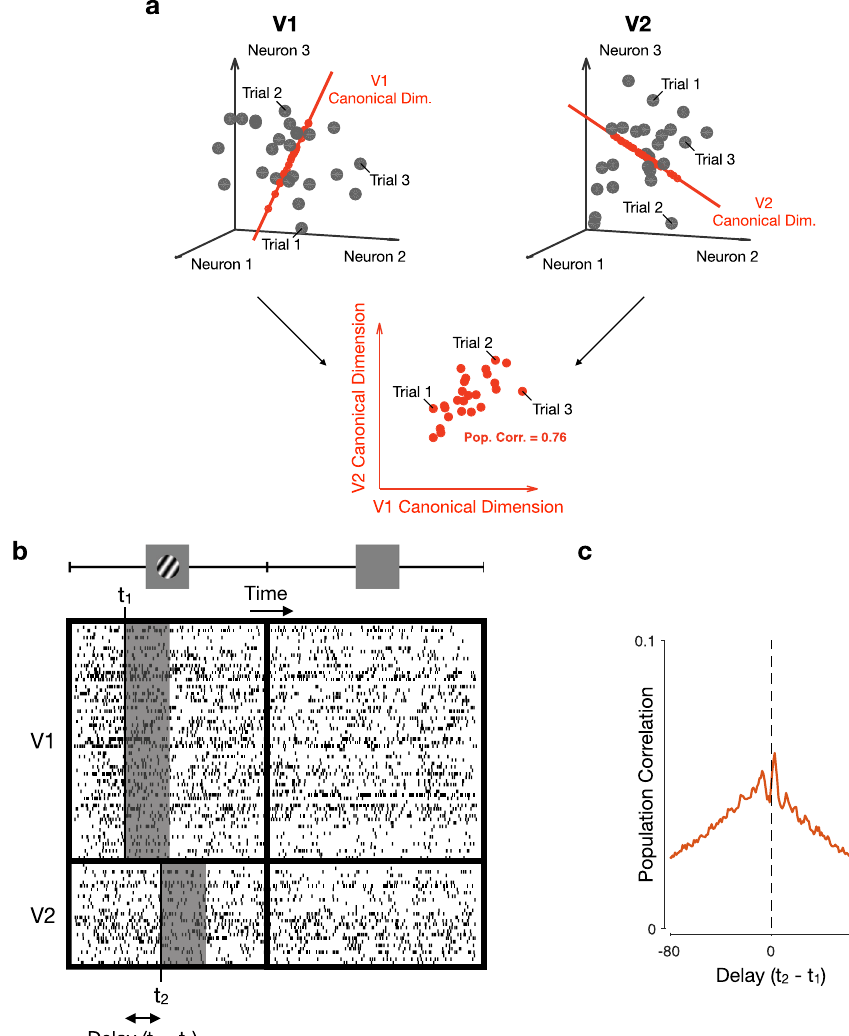
Fig. 2 Using Canonical Correlation Analysis (CCA) to capture population interactions. a Relating activity across two neuronal populations. Each circle represents the population activity recorded on a given trial. For each activity point observed in the V1 population (left panel; gray dots), there is a corresponding, simultaneously recorded activity point observed in V2 (right panel, gray dots). The red axes represent the fi rst pair of canonical dimensions, identi fi ed using CCA. Neuronal activity projected onto the fi rst pair of canonical dimensions (red dots) is highly correlated across the two areas (bottom panel). b Spike counts across the recorded neurons are taken in speci fi ed time windows (gray boxes), which may either be positioned at the same time in both areas (i.e., t 1 = t 2 ) or with a delay between areas ( t 1 ≠ t 2 ). The activity in each gray box is represented by a circle in panel (a). c The population correlation function corresponds to the correlation between areas returned by CCA (the correlation associated with the fi rst pair of canonical dimensions), as a function of the time delay between areas ( t 2 − t 1